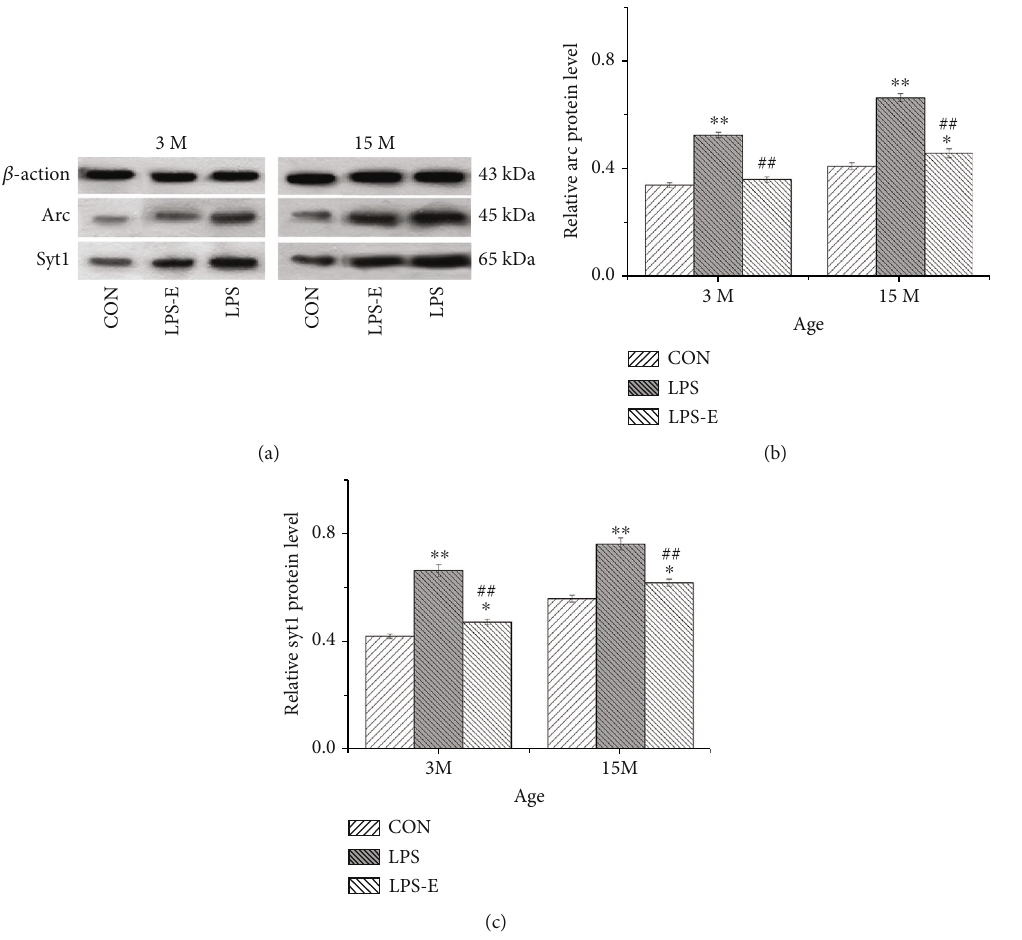
Figure 4: Representative immunoreactive bands for Arc and Syt1 (a) in the hippocampi of mice in di ff erent treatment groups at di ff erent ages. (b) Arc and (c) Syt1 protein levels in the hippocampi of mice at di ff erent ages in the di ff erent treatment groups ( n = 6 per group). Errorbars = SEM . ∗ P < 0 : 05 , ∗∗ P < 0 : 01 compared with the control group; ## P < 0 : 01 compared with the LPS group. CON: untreated control group; LPS: lipopolysaccharide treatment group; E: group of mice exposed to